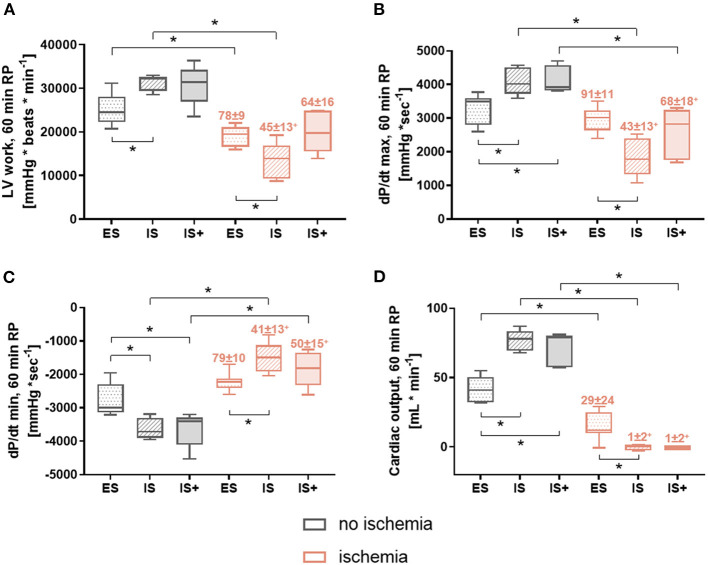
Post-ischemic cardiac function at 60 min reperfusion. (A) LV work (left ventricular work: heart rate*developed pressure) (B) dP/dt max (maximum first derivative of LV pressure) (C) dP/dt min (minimum first derivative of LV pressure) (D) CO (cardiac output). Data are expressed as median, 25–75 percentiles, and range; numbers indicate percentage of corresponding non-ischemic value. *p < 0.05, +p < 0.05 vs. ES. ES, ex-situ model; IS, in-situ model; IS+, in-situ model with cardioplegia; RP, reperfusion; n = 5–8 per group.